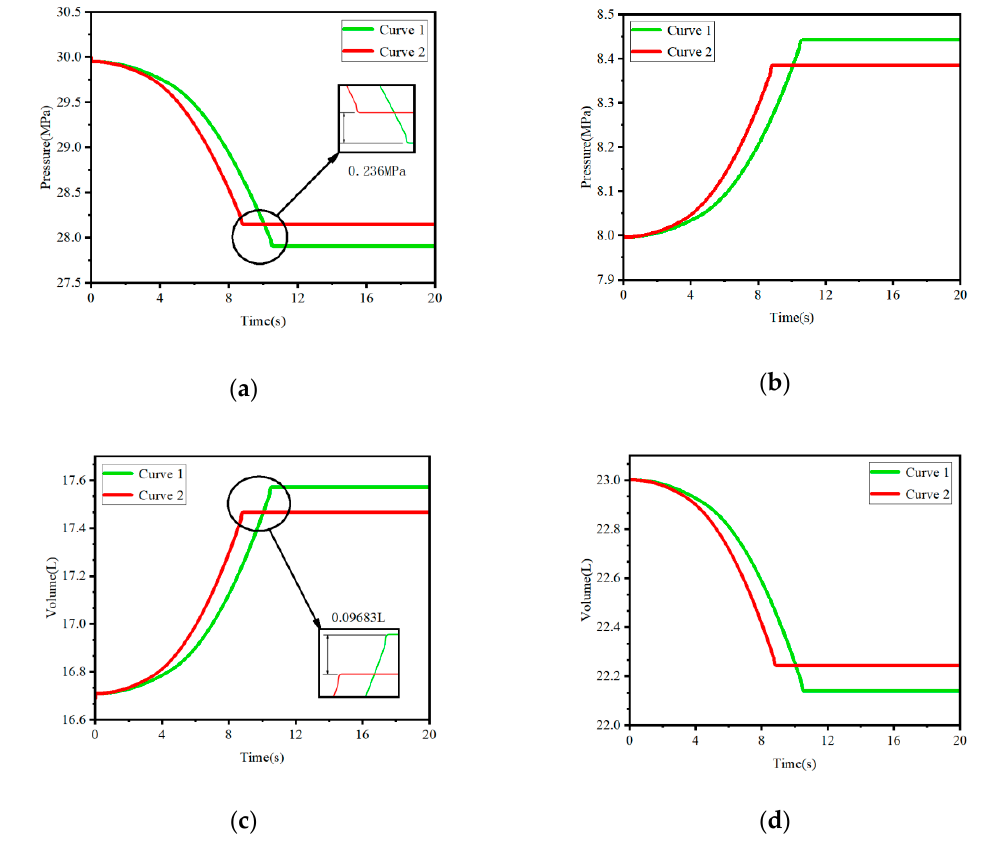
Figure 13. Diagrams of the oil pressure and gas volume of the MEH-DCDS with and without PID control. ( a ) is the comparison chart of oil pressure in high pressure accumulator, ( b ) is the comparison chart of oil pressure in low pressure accumulator, ( c ) is the comparison chart of gas volume in high pressure accumulator, and ( d ) is the comparison chart of gas volume in low pressure